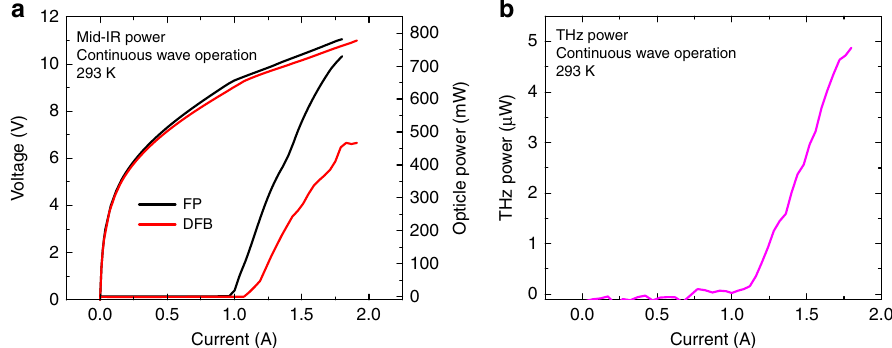
Fig. 4 Power characterizations of mid-IR and THz comb emissions. a Power-current-voltage (PIV) characterizations of the FP and DFB QCL combs with 4-mm long cavity and 9- μ m ridge width at room temperature continuous wave operation. b THz power characterization of the DFB QCL comb at room temperature continuous wave operation